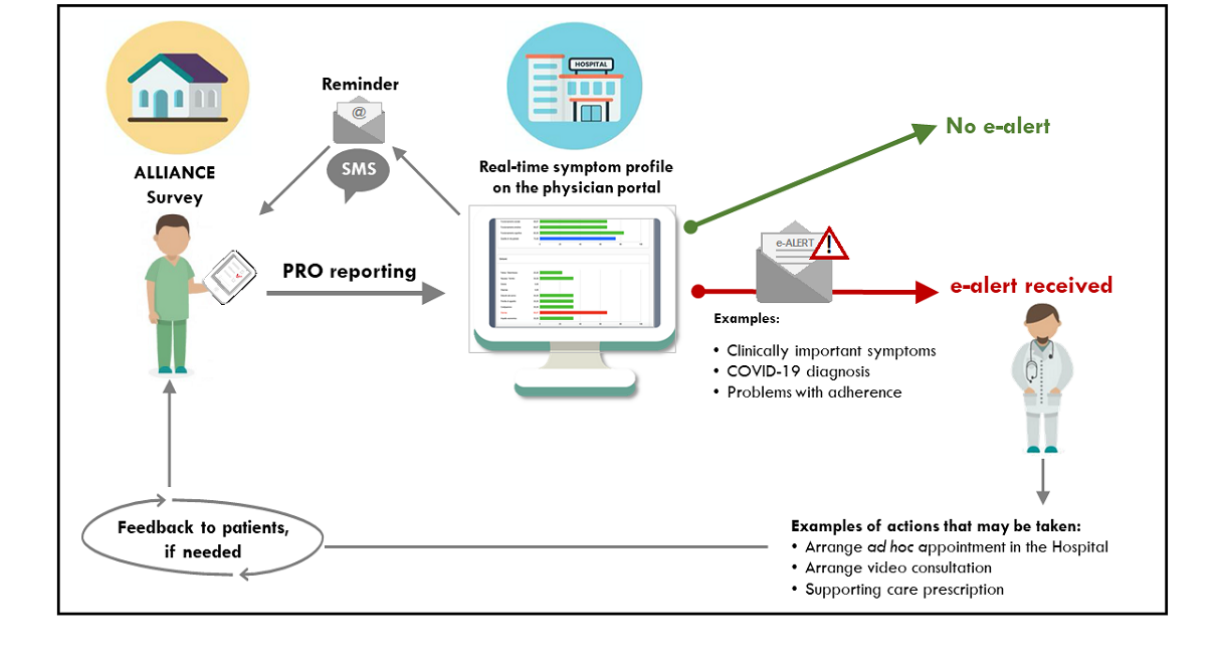
Figure 5. Schematic workflow of the patient-generated alerts to the medical team. ALLIANCE: An online platform to improve patient-centered